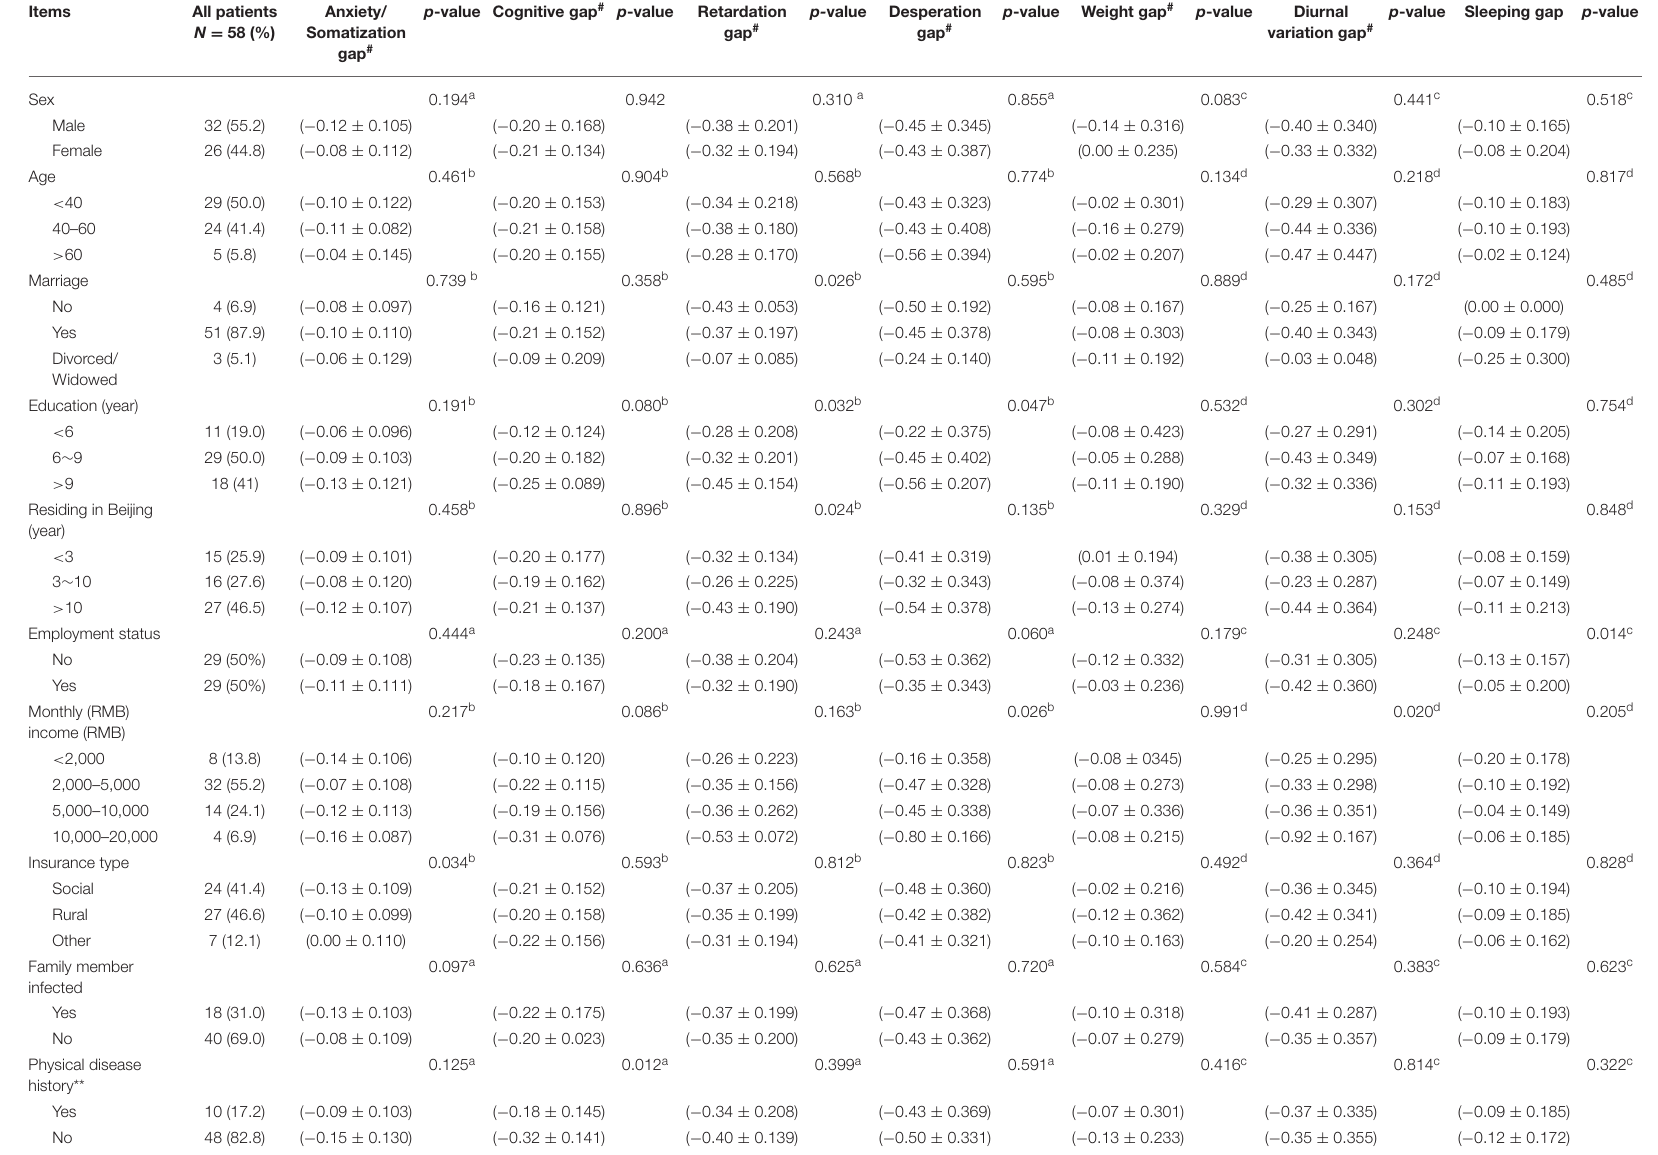
TABLE 2 | Gaps of SDS and HAMD scores among various demographic